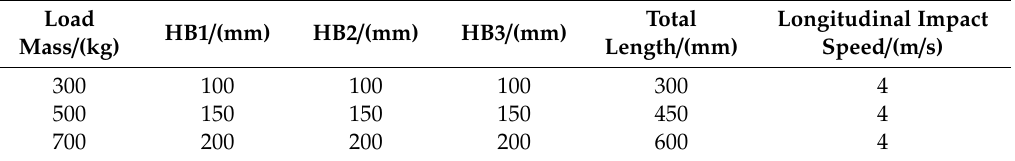
Table 3. Experimental parameters of cushioning material stamping simulation.